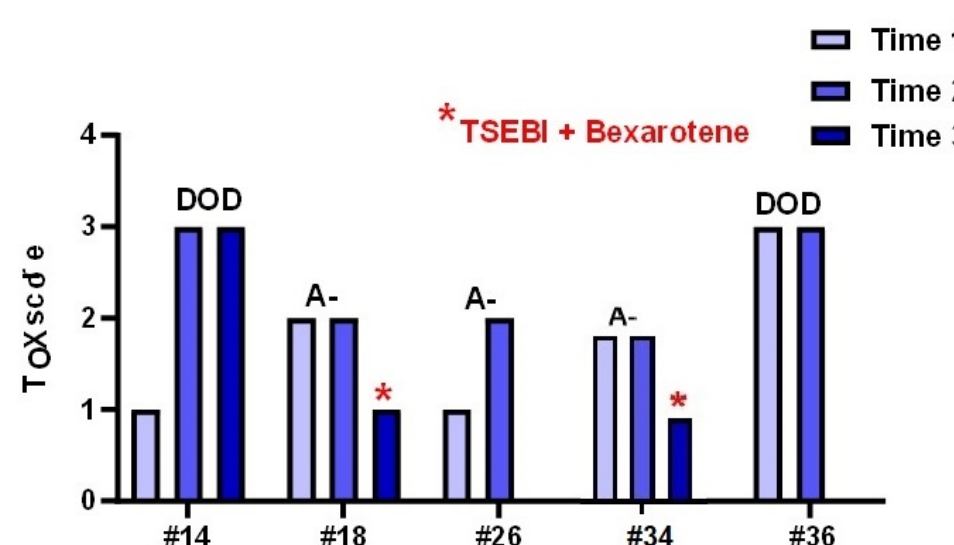
Figure 7. Tox expression in different biopsies of male patients performed during the clinical follow up of the disease.